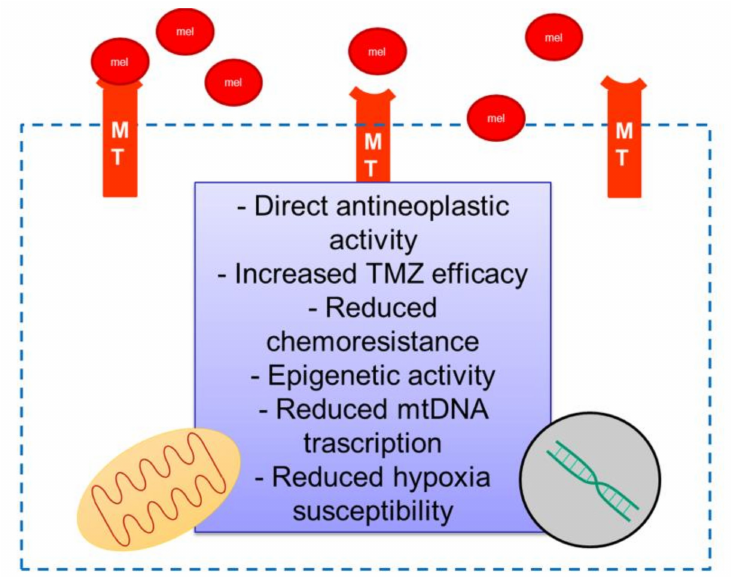
Figure 2. Melatonin may induce, in glioblastoma (GBM) cells, an intracellular transcription cascade, which, in turn, leads to an antineoplastic response reducing / blocking oncogene expression, chemoresistance, and other cellular mechanisms. Mel: melatonin; MT: melatonin receptor; mtDNA: mitochondrial DNA; TMZ: